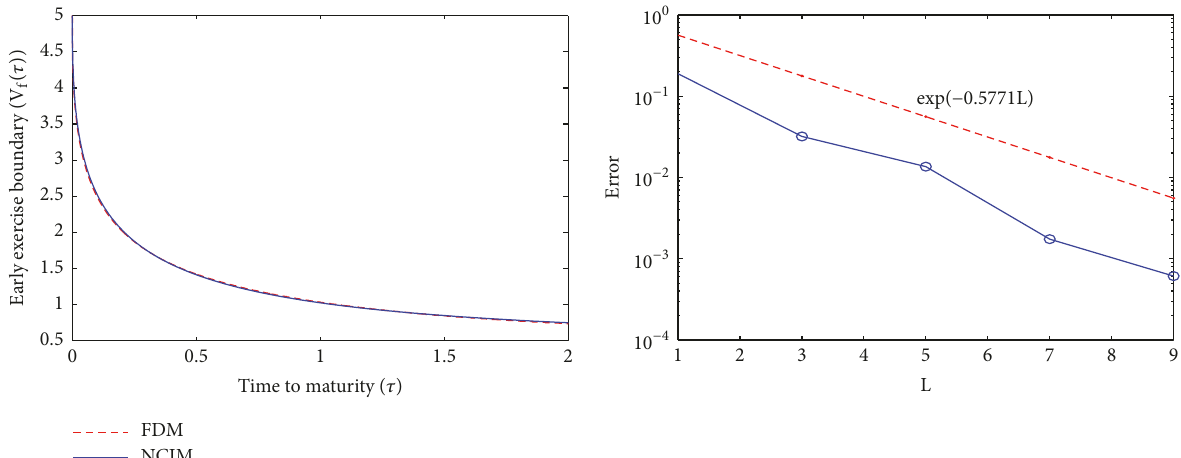
Figure 4: Early exercise boundaries (left) under MRSRP model with 𝑇/2000 for FDM and 𝐿 = 10 for NCIM, NCIM errors in log-scale versus 𝐿